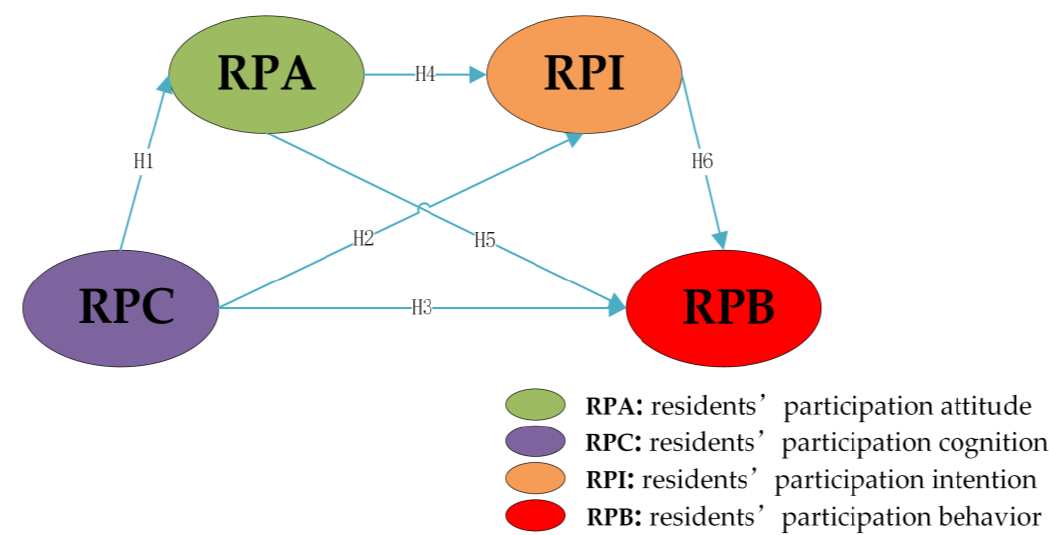
Figure 1. Conceptual framework of the determinants of the RPB in the SOCR.